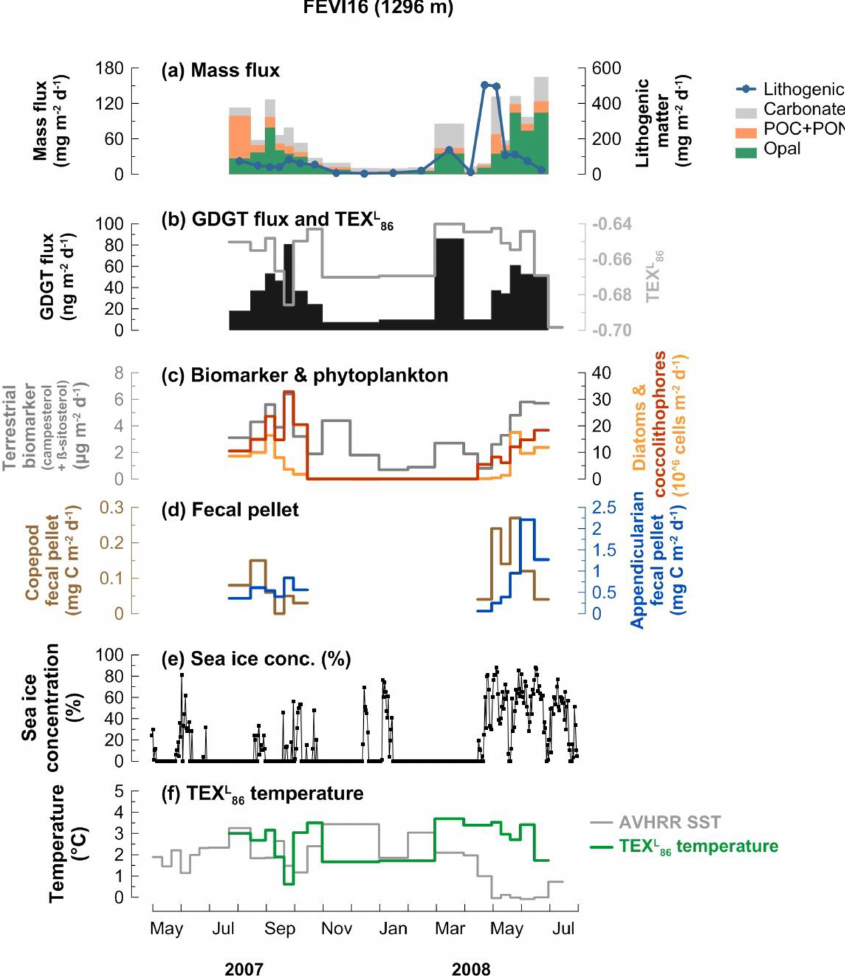
Figure 3. Changes in mass flux (a) , GDGT flux (b) , terrestrial biomarker flux and diatom and coccolithophore abundances (c) , fecal pellet flux (d) , sea ice concentration (e) , and TEX L -derived temperatures and satellite-derived SSTs obtained at 79.125 ◦ N, 4.375 ◦ E near the trap 86 site (f) at 1296m water depth at the eastern Fram Strait site, FEVI16, during the deployment period July 2007–July 2008. Panels (a) , (c) , (d) , and (e) were previously reported by Lalande et al.